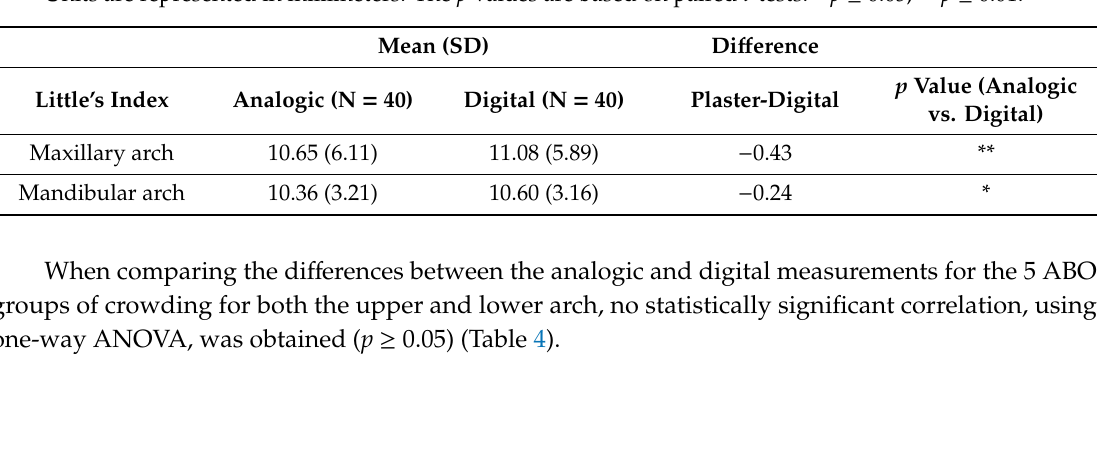
Table 3. Di ff erences in Little’s Irregularity Index measurements between the plaster and digital models. Units are represented in millimeters. The p values are based on paired t -tests. * p ≤ 0.05; ** p ≤